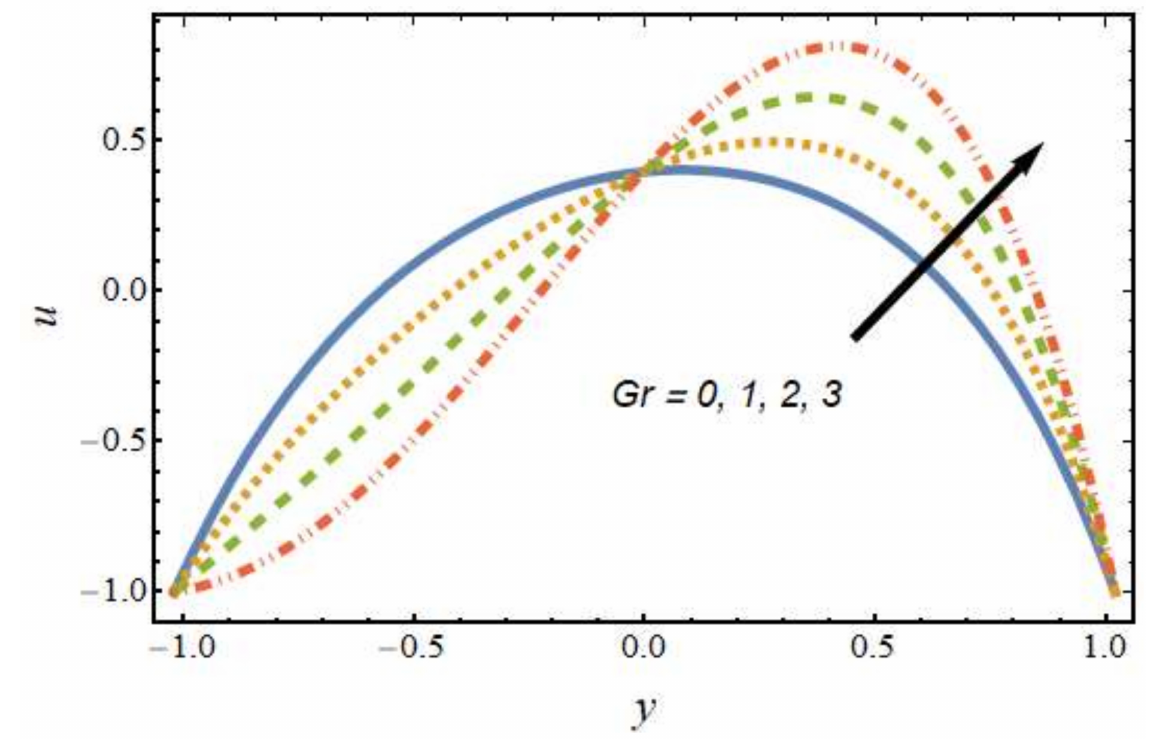
Figure 6. Velocity profile for various values of the Grashof number.